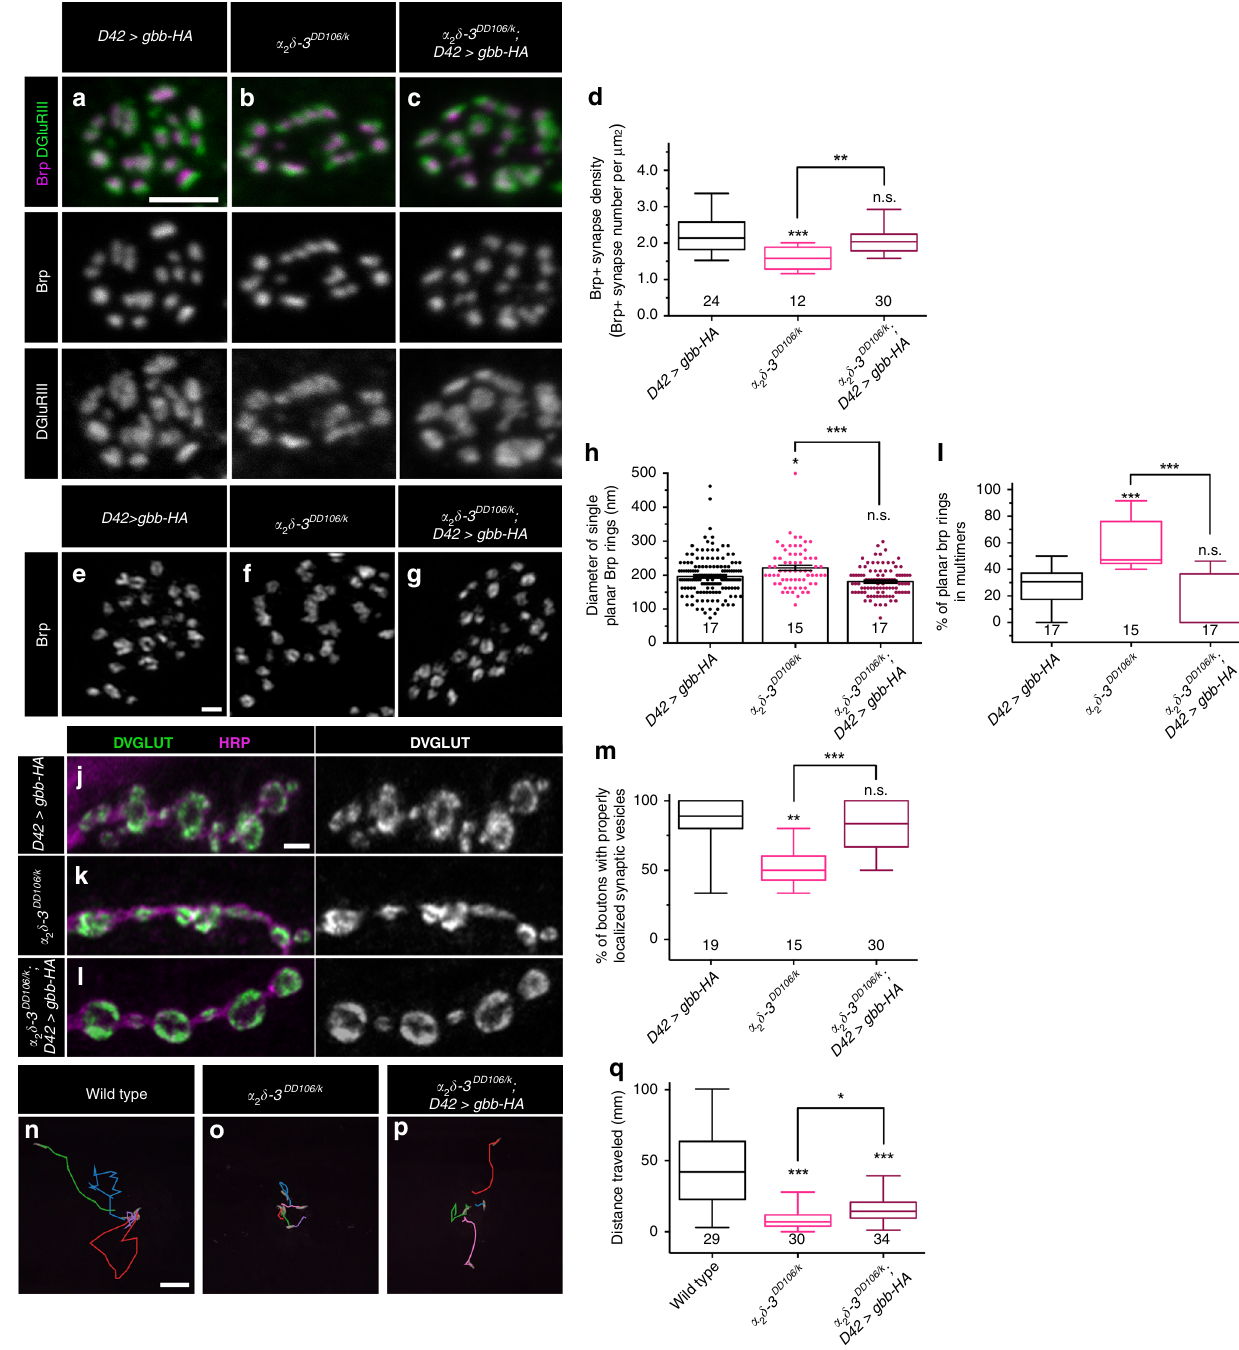
Fig. 8 Overexpressing presynaptic Gbb suppresses α 2 δ -3 mutant phenotypes. a – c Representative z-projections of boutons of the indicated genotypes labeled with Brp (magenta) and DGluRIII (green). Scale bar: 2 µ m. d Quanti fi cation of the Brp + synapse density. n is the number of boutons scored. e – g Representative deconvolved z-projections of boutons of the indicated genotypes labeled with anti-Brp. Scale bar: 1 µ m. h Quanti fi cation of single planar Brp ring diameters. ( i ) Quanti fi cation of the percentage of planar Brp rings in multimers in boutons. For Brp ring analyses, n is the number of boutons scored. j – l Representative z-projections of boutons of the indicated genotypes labeled with DVGLUT (green) and HRP (magenta). Scale bar: 2 µ m. m Quanti fi cation of the percentage of boutons exhibiting properly localized synaptic vesicles. n is the number of NMJs scored. n – p Representative traces of third-instar larvae of the indicated genotypes crawling for 3 min. Each color represents an individual larva. Scale bar: 10 mm. q Quanti fi cation of the total distance traveled by larvae of the indicated genotypes. n is the number of larvae scored. For the bar graph, error bars are mean ± SEM. For all box-and- whisker plots, error bars are min and max data points, and the center line indicates the median. Individual data points are displayed as dots. n.s., not signi fi cantly different. * p < 0.05; ** p < 0.01; *** p < 0.001. All tests are nonparametric Kruskal-Wallis one-way ANOVAs on ranks followed by Dunn ’ s multiple comparison